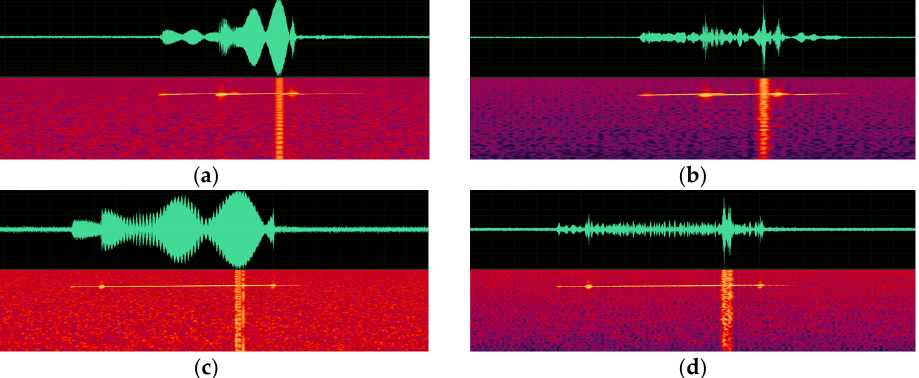
Figure 10. Spectrograms of active sonar signals with various pulse duration parameters. ( a ) An original signal with a pulse duration of 160 ms. ( b ) A synthesized signal with a pulse duration of 160 ms. ( c ) An original signal with a pulse duration of 770 ms. ( d ) A synthesized signal with a pulse duration of 770 ms.